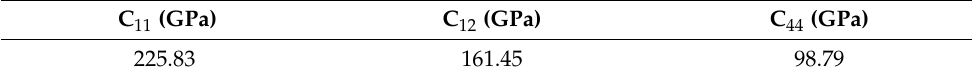
Table 2. Elastic constants of IN-738 LC at 850 °C .